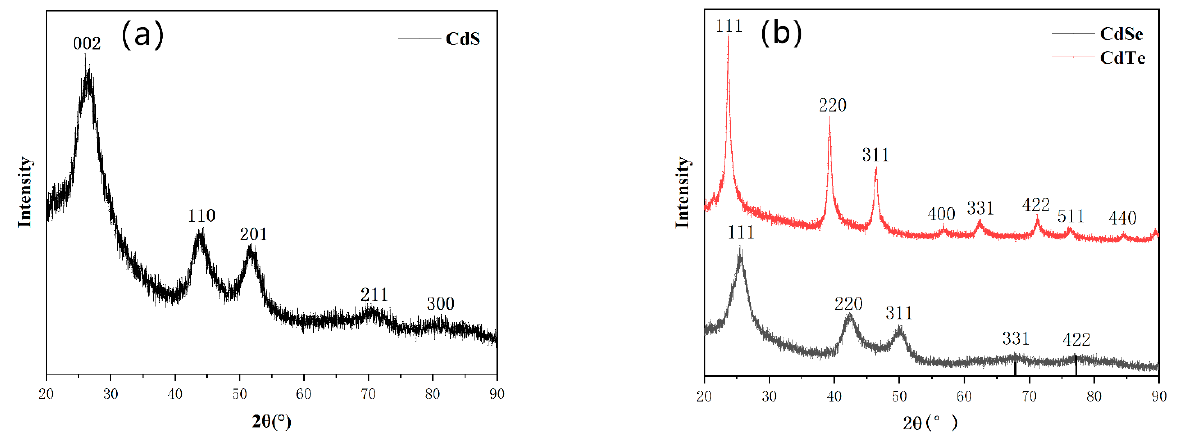
Figure 3. The XRD pattern of the ( a ) CdS ( b ) CdSe, and CdTe NCs.